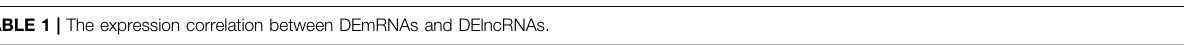
TABLE 1 | The expression correlation between DEmRNAs and DElncRNAs. Group LncRNA up-up mRNA LncRNA up-down mRNA LncRNA down- up mRNA LncRNA down-down mRNA EAU vs. Ctrl 5,569 24 103 107,659